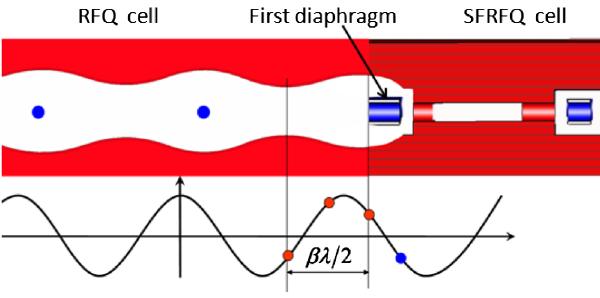
FIG. 4. Cross section ( x - z plane of the coupled RFQ-SFRFQ (the three red points and one blue point in the cosine curve refer to the evolution of the synchronous phase).